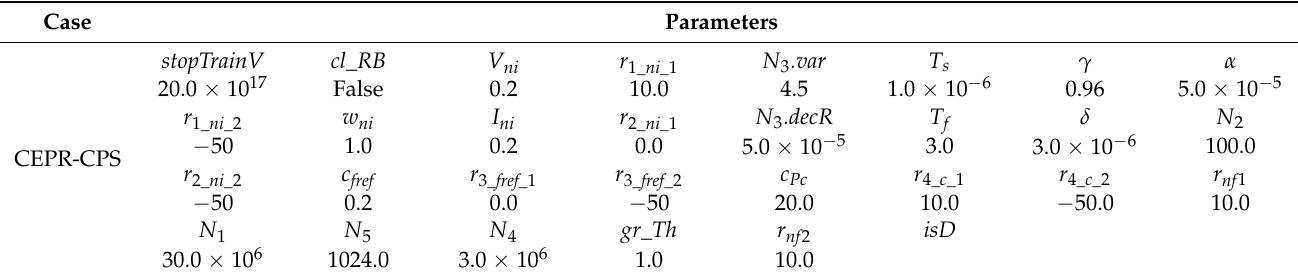
Table 2. Parameters used in the PCP construction method based on deep deterministic policy gradient idea (PCMD) for the